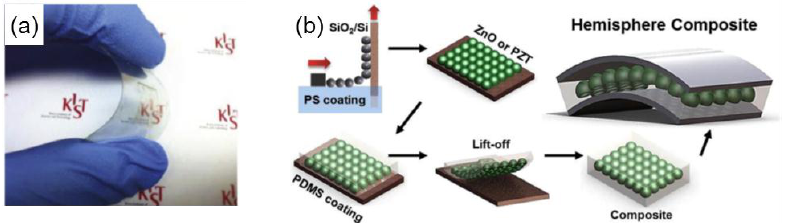
Figure 6. ( a ) Transparent flexible piezoelectric energy harvester based on PZT films by LLO process [78]; ( b ) highly-stretchable composite nanogenerator using hemisphere PZT thin film [82].